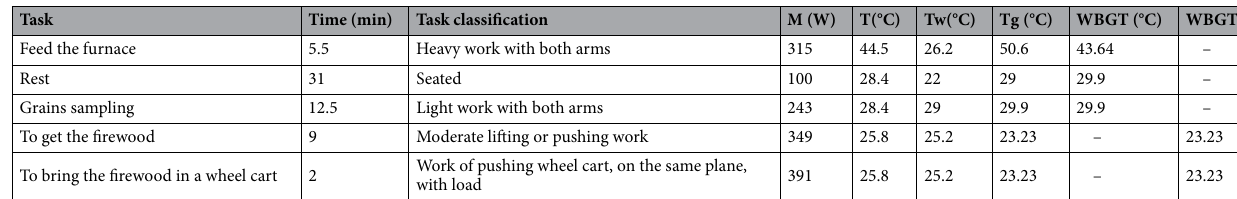
Table 5. Thermal stress measurement at wood supply to the furnace activity. Where: M = metabolic rate; WBGT * = outdoor activities with direct solar